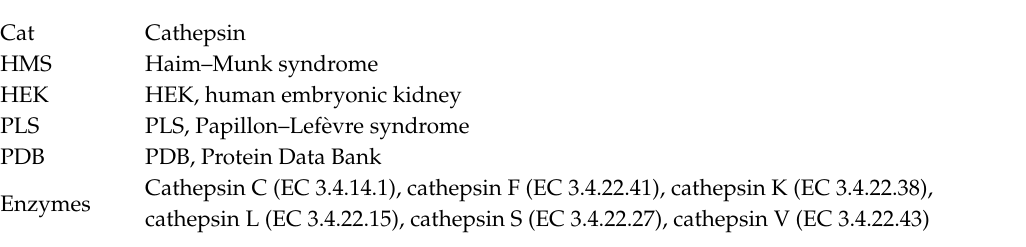
Figure S2: ProCatC processing by calpain-1, trypsin and CatG. Videos: ProCatC dimers in a dynamic equilibrium with an “open” and a “closed” conformation. The activation domain is colored in red. PDB files of proCatC model structures (monomer and